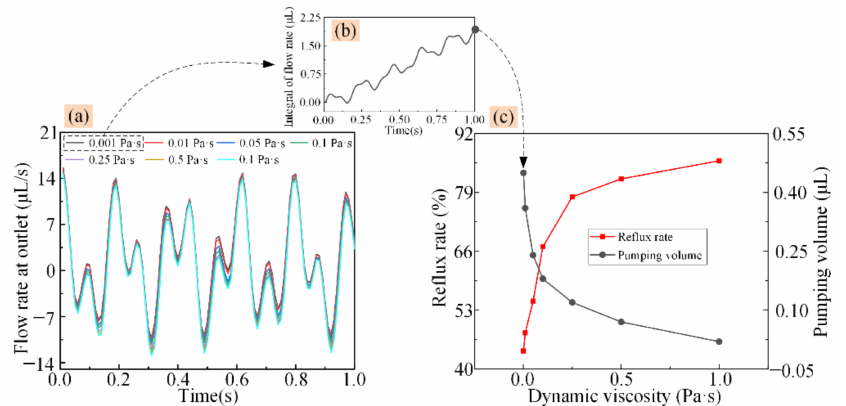
Figure 9. The pumping performance of the design when fluids of different viscosities were pumped. ( a ) Frequency of flow rate versus the fluid’s viscosity, ( b ) Integral results of the flow rate for the fluid viscosity of 0.001 Pa · s, and ( c ) The pumping volume and reflux rate versus differing fluid viscosities.